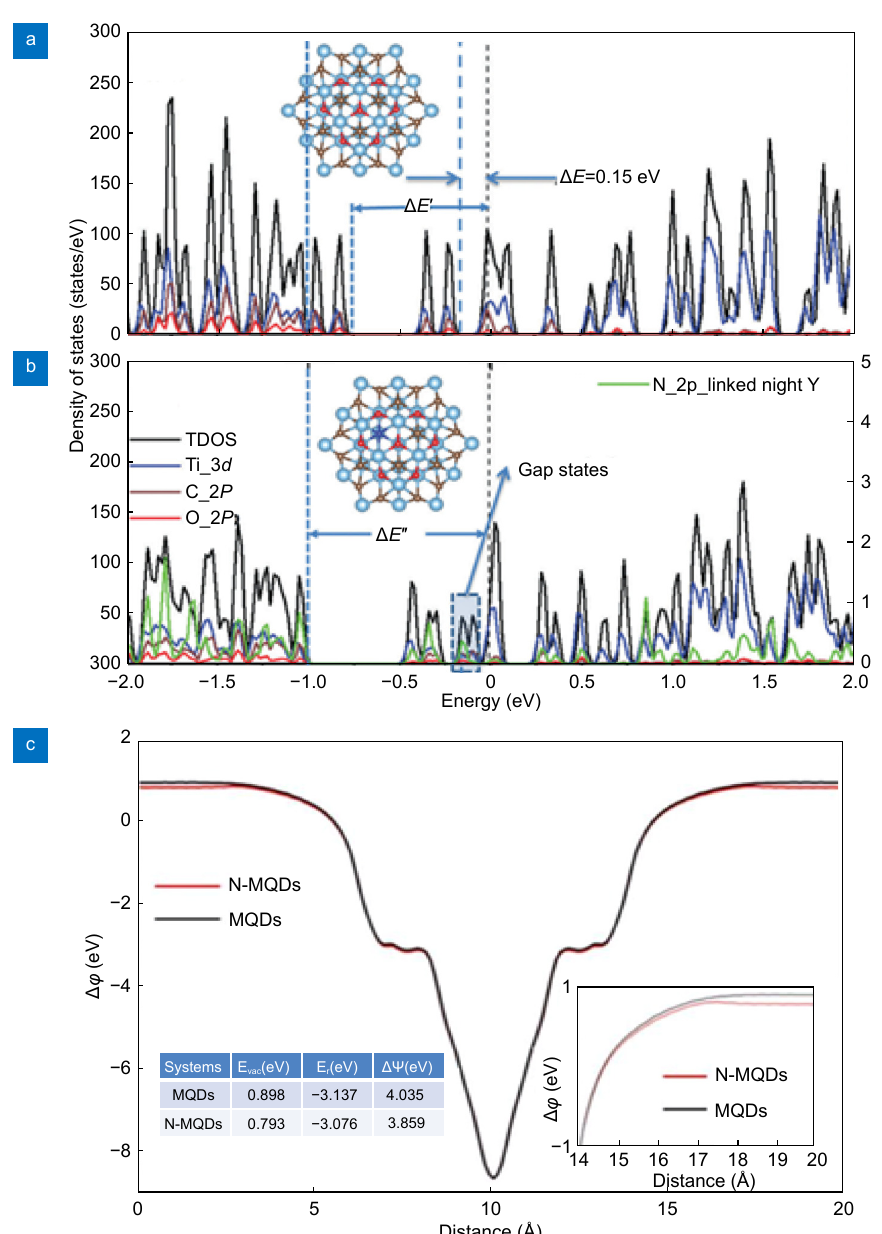
Fig. 7 | DFT calculation of total and projected density of states of ( a ) Ti 3 C 2 O 2 QDs and ( b ) Ti 3 C 2- x N x O 2 QDs. ( c ) Work function of pristine Ti 3 C 2 QDs (MQDs) and N-MQDs. Figures were reproduced with permission from ref. 34 . Copyright 2018, Royal Society of